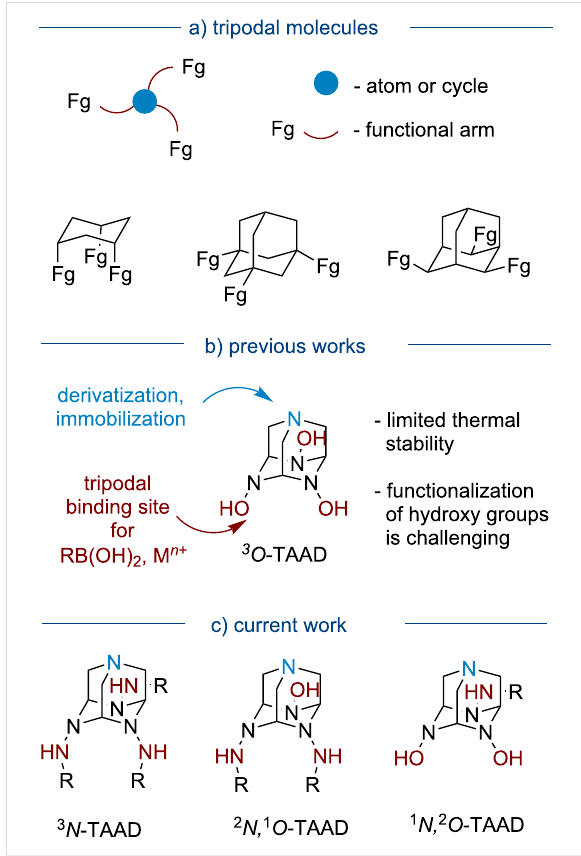
Figure 1: Adamantane-based tripodal scaffolds and current work.